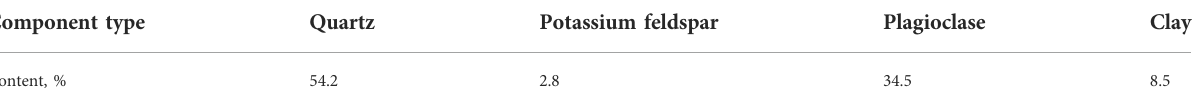
TABLE 2 Initial sample samples ’ mineral composition.